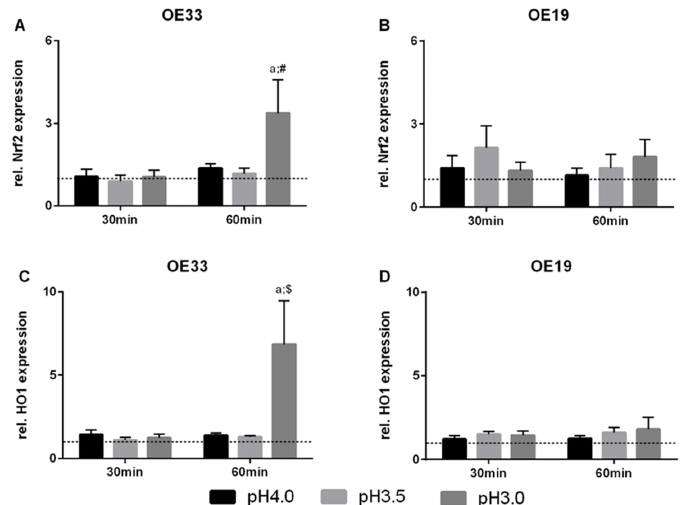
Figure 4 . Gene expression in EAC cells after acute acid exposure. Expression of Nrf2 ( A , B ) and HO1 ( C , D ) were assessed via quantitative RT-PCR. OE33 and OE19 cells were treated once (acute) with acidic medium for 30 and 60 min. Values are shown as mean ± S.E.M. (Two-way ANOVA with Sidak’s multiple comparisons test; a— p < 0.001, compared to control; $— p < 0.01, #— p < 0.05, compared to 15